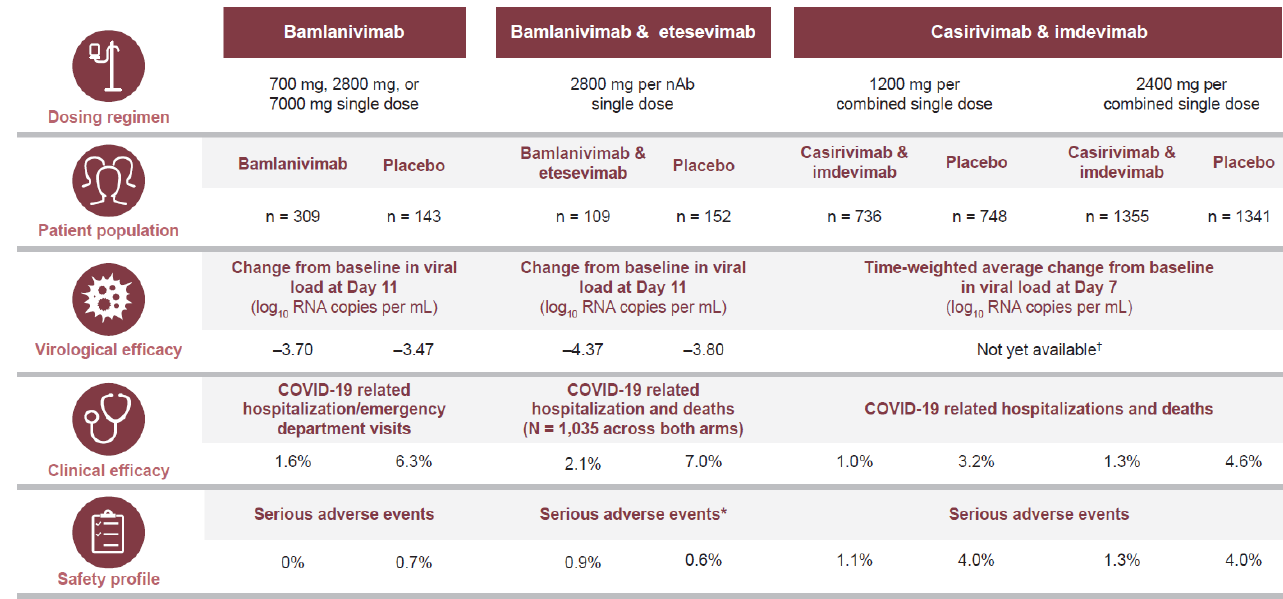
Figure 2. Comparison of the Key Clinical, Virological and Safety Data for Neutralizing Antibodies with EUA for Treatment of Ambulatory Patients with COVID-19. * Based on 112 patients (combination arm) and 156 patients (placebo arm). † Interim data from the phase 1/2 portion of the trial reported a time-weighted average change from baseline of −1.74 log 10 RNA copies per mL in casirivimab/imdevimab-treated patients (n = 143; combined results from 2400 mg and 8000 mg dose arms) versus a −1.34 log 10 RNA copies per mL change from baseline in the placebo arm (n = 78).